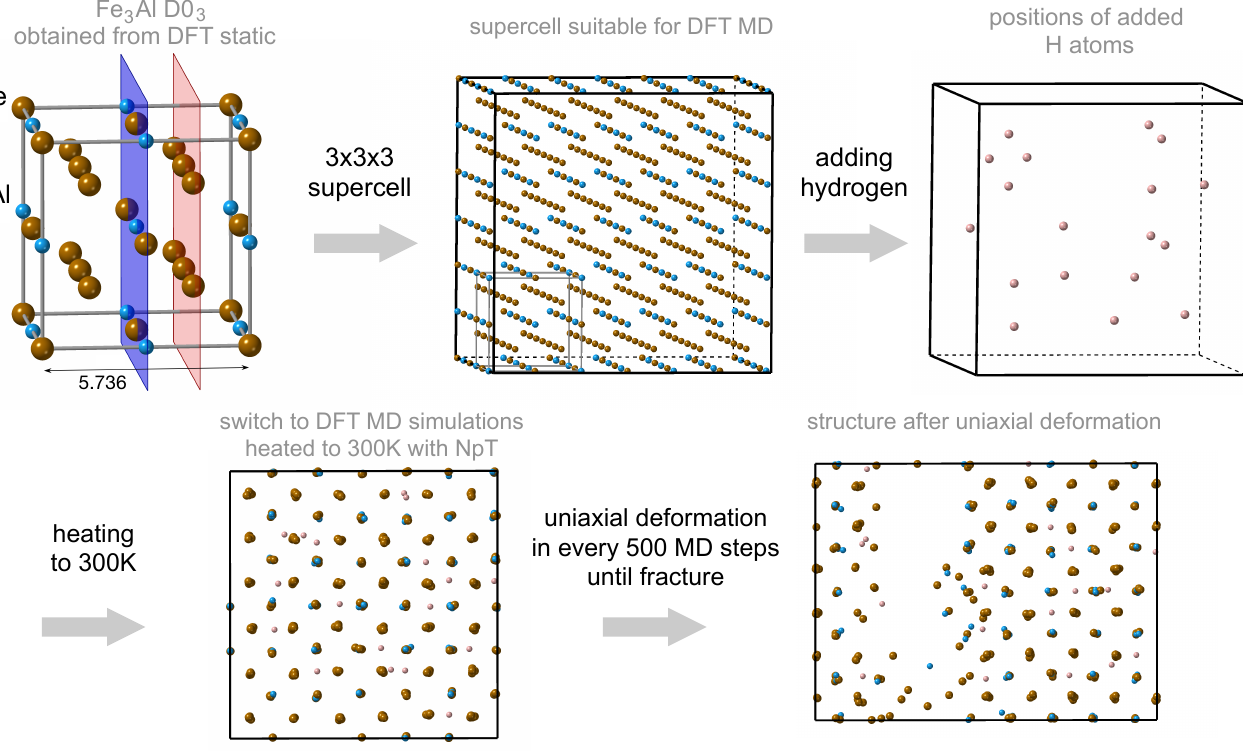
Figure 1. A schematic visualization of our ab initio molecular-dynamics computational set-up aimed at determing the impact of H atoms on Fe 3 Al under uniaxial deformation along the (cid:104) 001 (cid:105) crystallographic